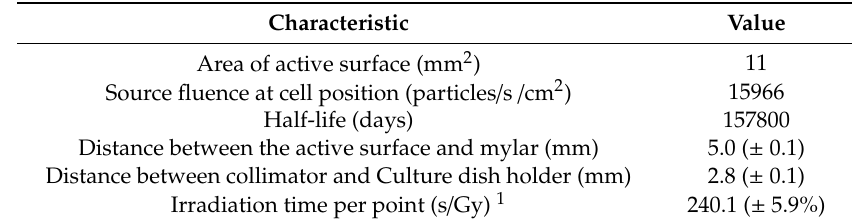
Figure 3. Schematic side views of both irradiation procedures. ( A ) Procedure 3.4.1 is meant for large field irradiation. Cells are grown in Mylar dishes. During the irradiation the active surface is mobile and irradiates the whole area covered with cells. ( B ). Procedure 3.4.2 is meant for coverslip irradiation. In this procedure the active surface is stationary and irradiates the coverslip. Table 1. Characteristics of the described 241 Am source and current setup. Adapted from [24]. Used for calculating the irradiation